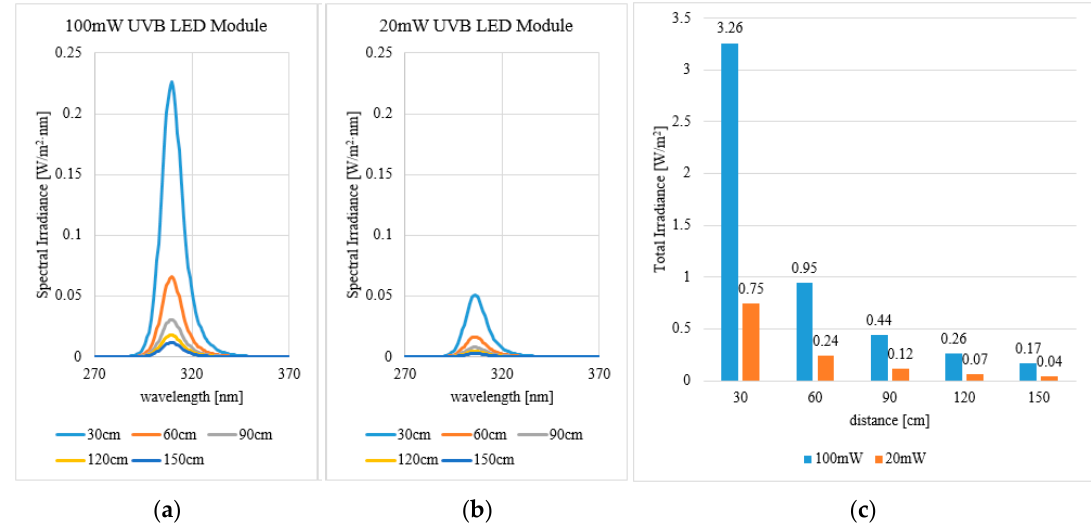
Figure 3. Irradiance and spectral irradiance by distance step. ( a ) Measured results per wavelength increments: 100 mW UVB LED module; ( b ) measured results per wavelength increments: 20 mW UVB LED module; ( c ) irradiance calculation result by distance step.